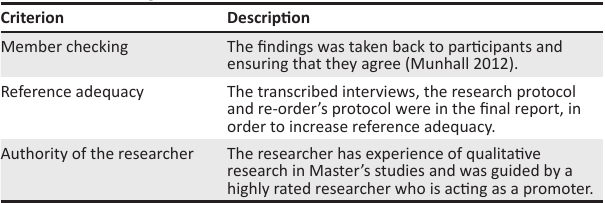
TABLE 1: The strategies used to ensure truth